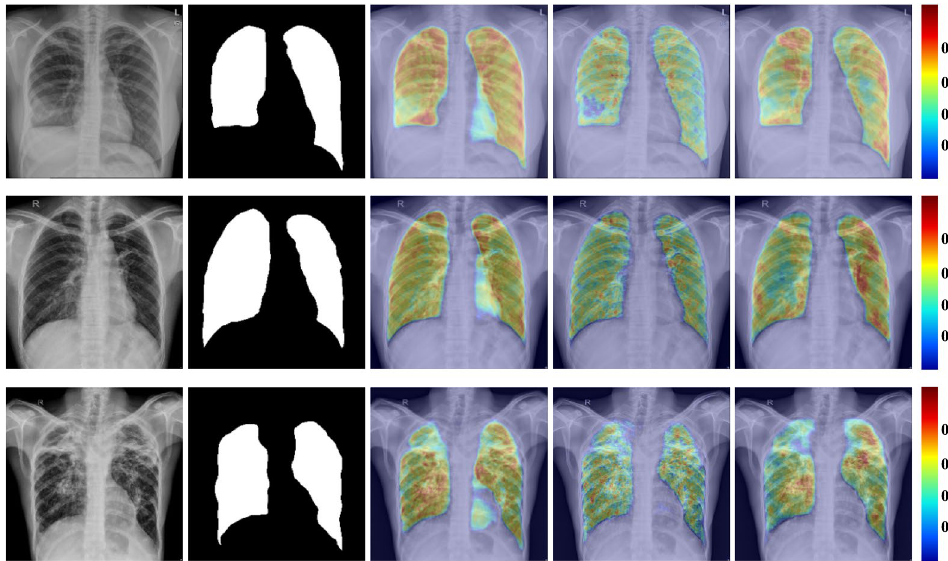
Figure 5. Class activation map (CAM) for the lung region. From left to right: inputs, groundtruth labels, U-Net CAM, Linknet CAM, and the proposed method CAM.